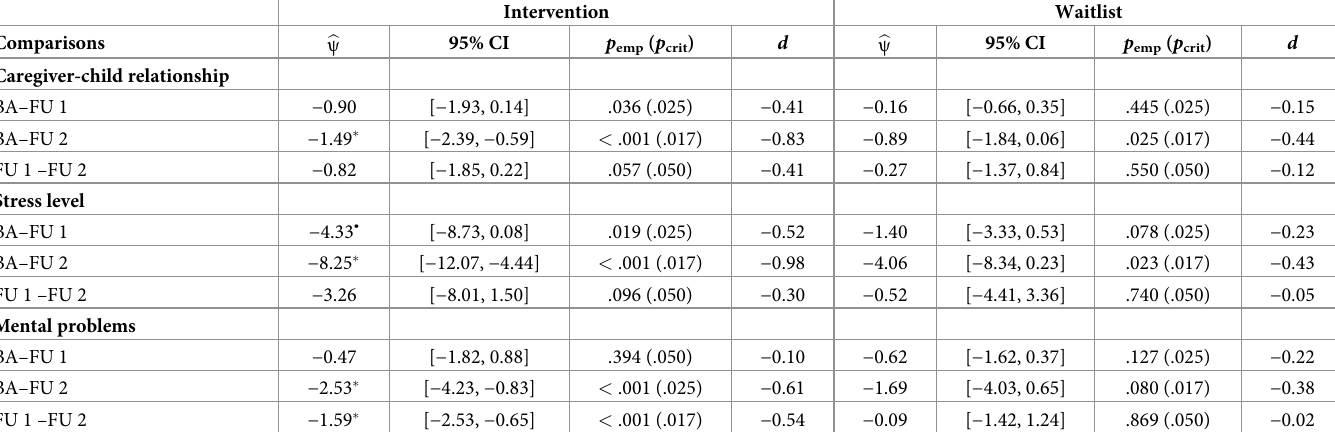
Table 4. Pairwise comparisons of the training effect in the secondary outcomes separated by intervention and waitlist